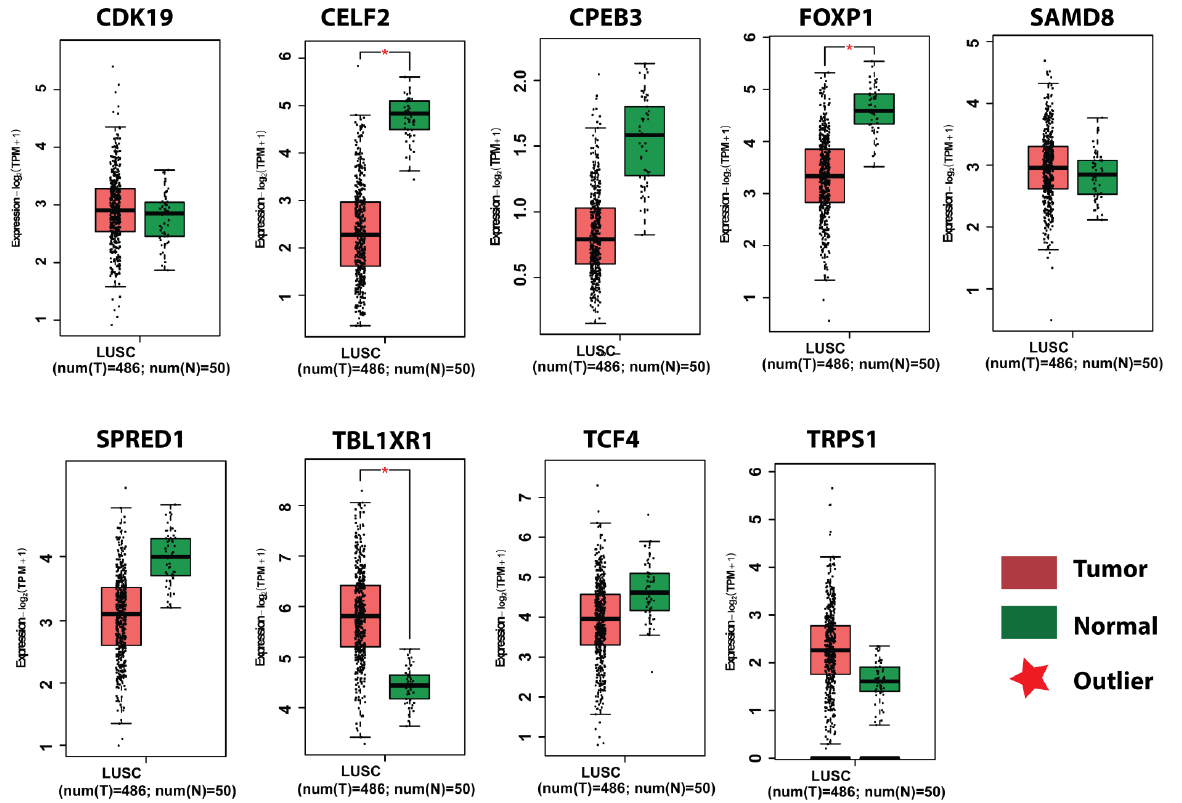
Figure 11. Expression analysis of selected key genes CPEB3 , SAMD8 , FOXP1 , TRPS1 , TCF4 , TBL1XR1 , SPRED1 , CELF2 , and CDK19 . Box plots obtained from GEPIA showing expression profiles of key genes in tumor (red) and normal (green) samples of LUSC datasets ( p < 0.05) in patients with NSCLC. ‘Outlier’ represents the statistical difference in gene expression between two boxplots.